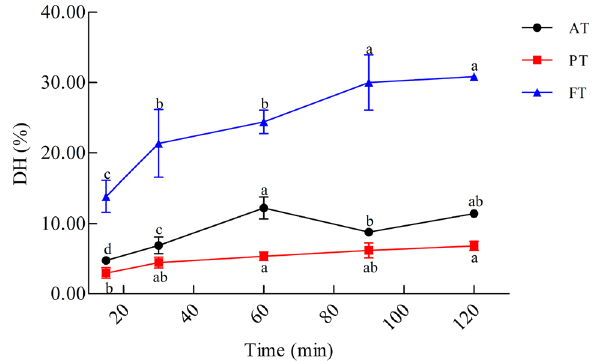
Figure 2. The degree of hydrolysis (DH) of CM with different enzymatic hydrolysis time. Alcalase-treated cow milk (AT), Protamex-treated cow milk (PT), Flavourzyme-treated cow milk (FT). Each value represents the mean of three independent experiments ± SD. Different letters indicate significant differences among groups ( P < 0.05).